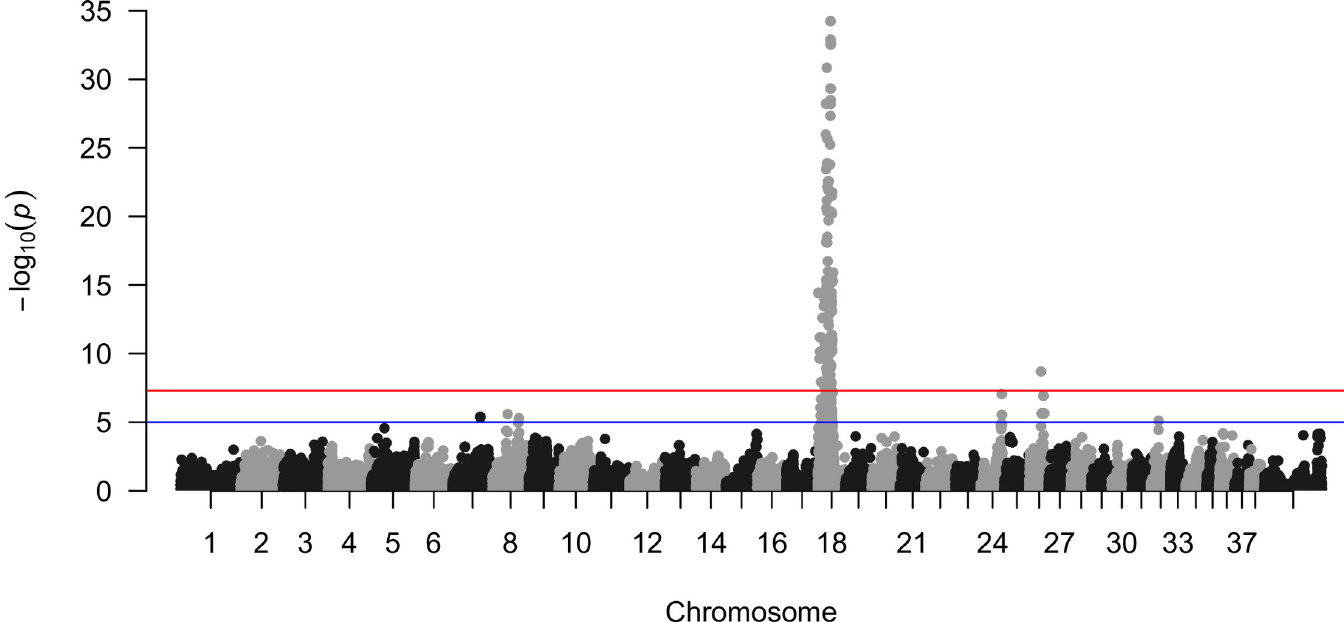
Fig 1. A Manhattan plot of association with Early Onset Adult Deafness (EOAD) in Rhodesian Ridgebacks. Red and blue horizontal lines are significant (P < 5 x 10 − 8 ) and suggestive (P < 1 x 10 − 5 ) associations, respectively.